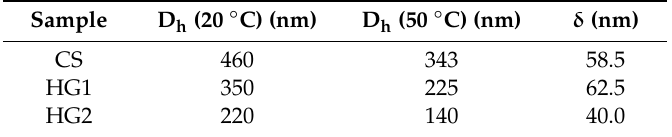
Colloidal characteristics of cationic core-shell and anionic nanohydrogel latexes. Hydrodynamic mean particle size (z-average) was determined by quasi-elastic light scattering (QELS);